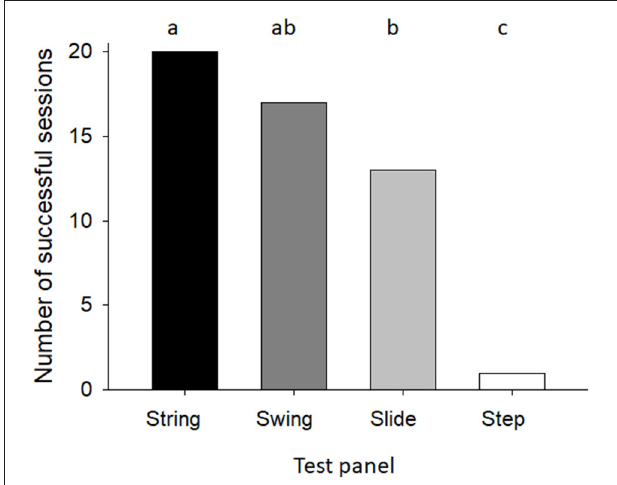
FIGURE 3 | Merged successful sessions of both laying hen groups for the four test panels: swing panel (black), string panel (dark gray), slide panel (light gray), and step panel (white). Different letters above the bars indicate significant differences in pairwise post-hoc comparisons between the test panels. The single success with the step panel was due to a malfunction of the